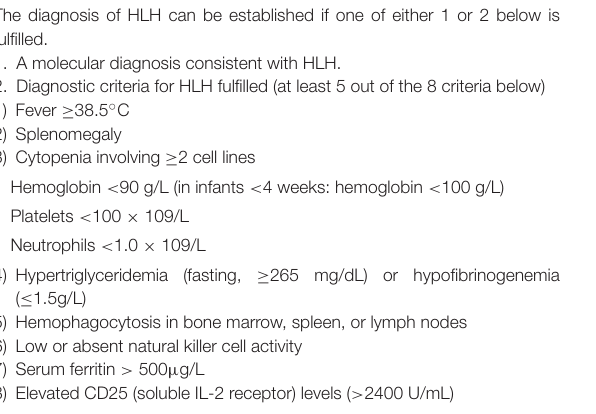
TABLE 3 | Diagnostic guidelines for HLH used in the HLH-2004 trial. The diagnosis of HLH can be established if one of either 1 or 2 below is